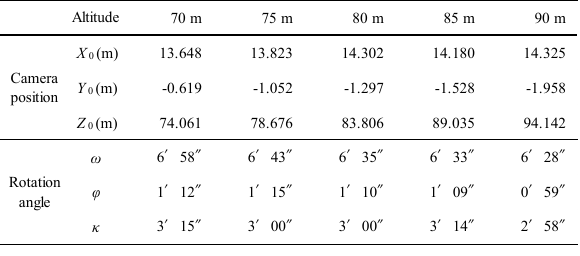
Table 2. Results of final orientation